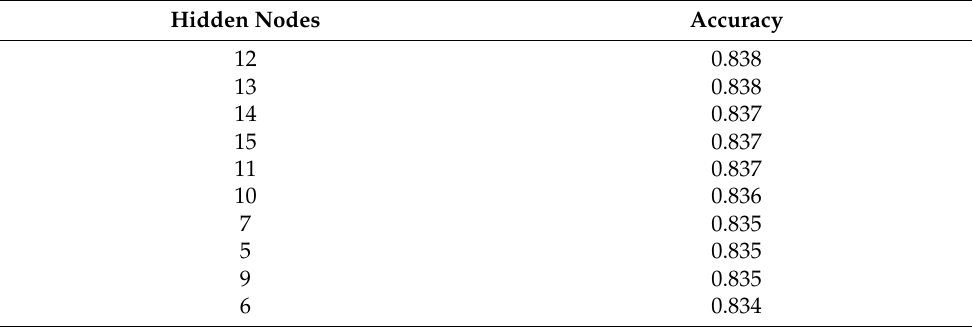
Table 3. Average accuracy values for each experiment (the higher the